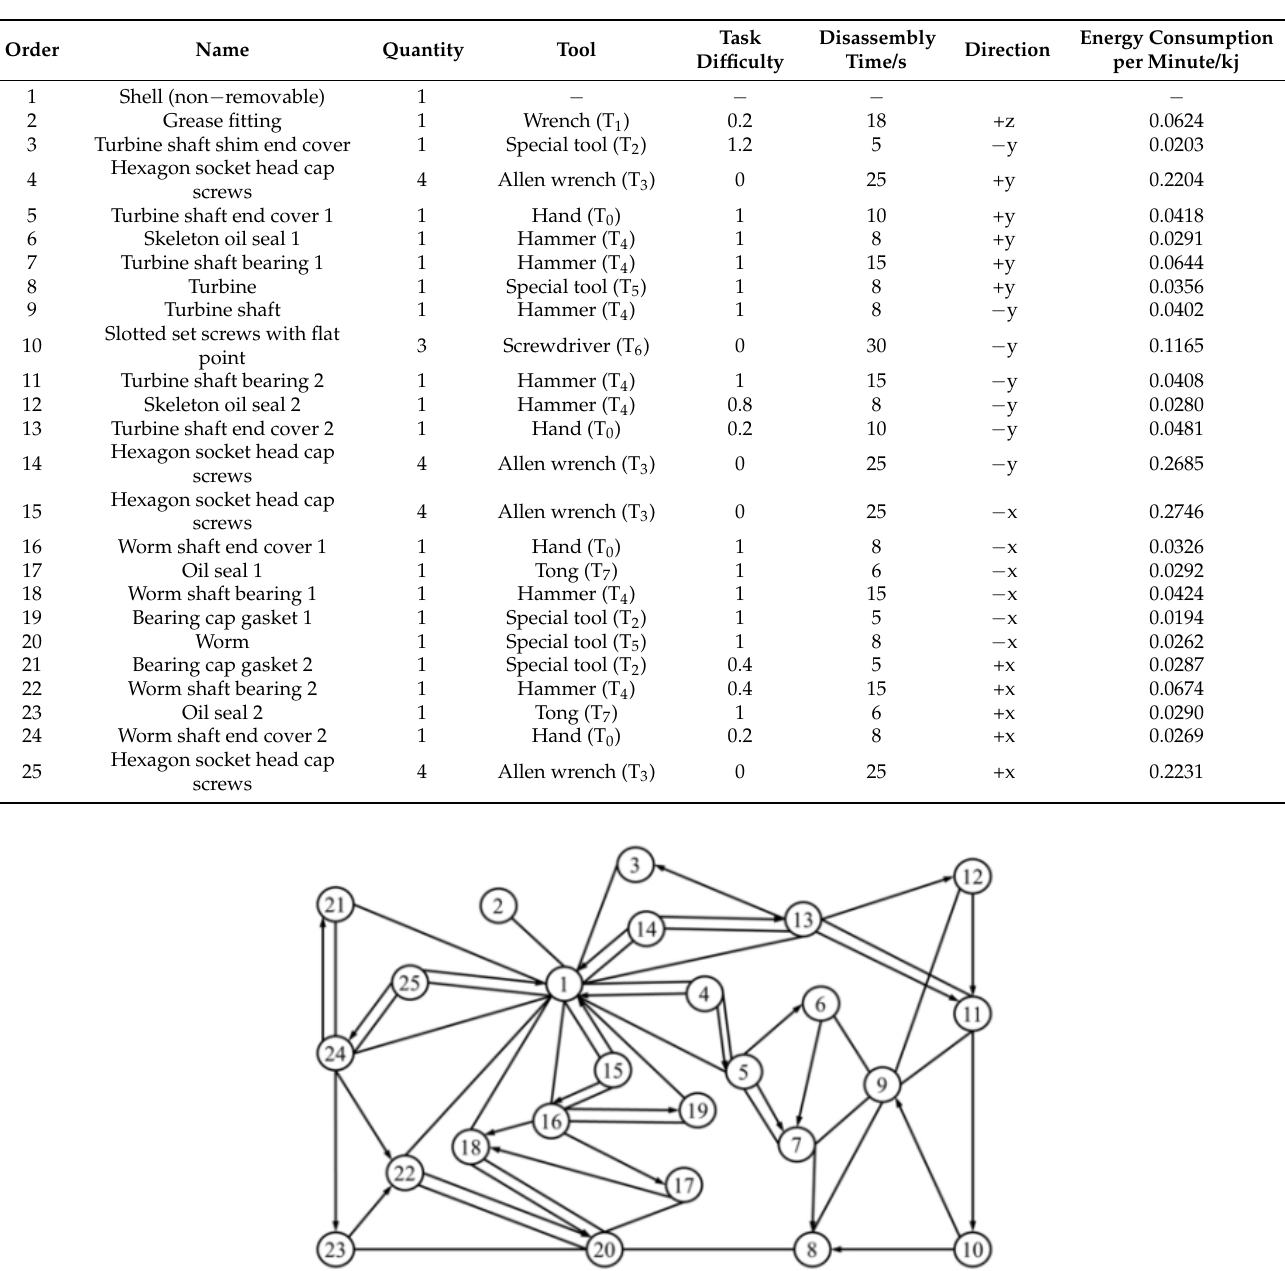
Figure 9. Box plot of run results when the population is 5.